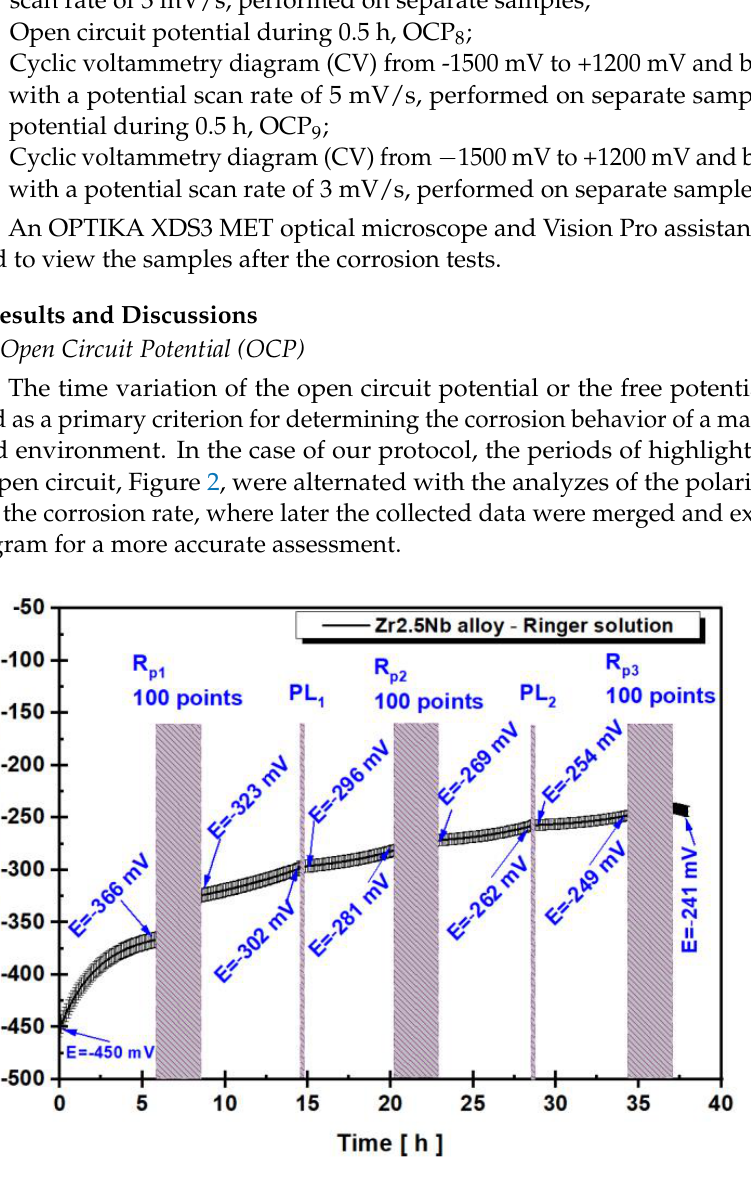
Figure 2. Evolution of the free potential (OCP) of the Zr2.5Nb alloy immersed in Ringer’s solution for 38.5 h.